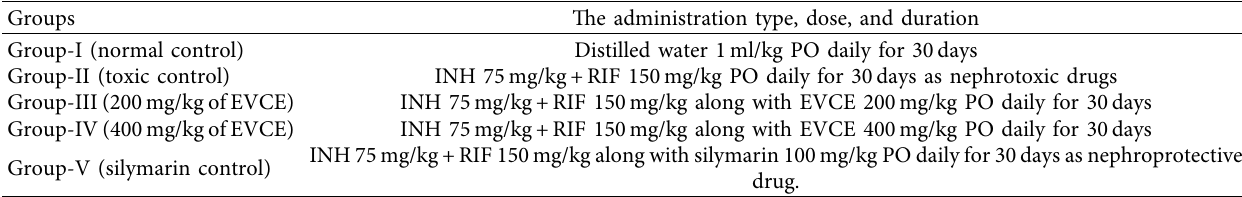
Table 1: Grouping of experimental animals and treatment protocols. Groups The administration type, dose, and duration Group-I (normal control) Distilled water 1 ml/kg PO daily for 30days Group-II (toxic